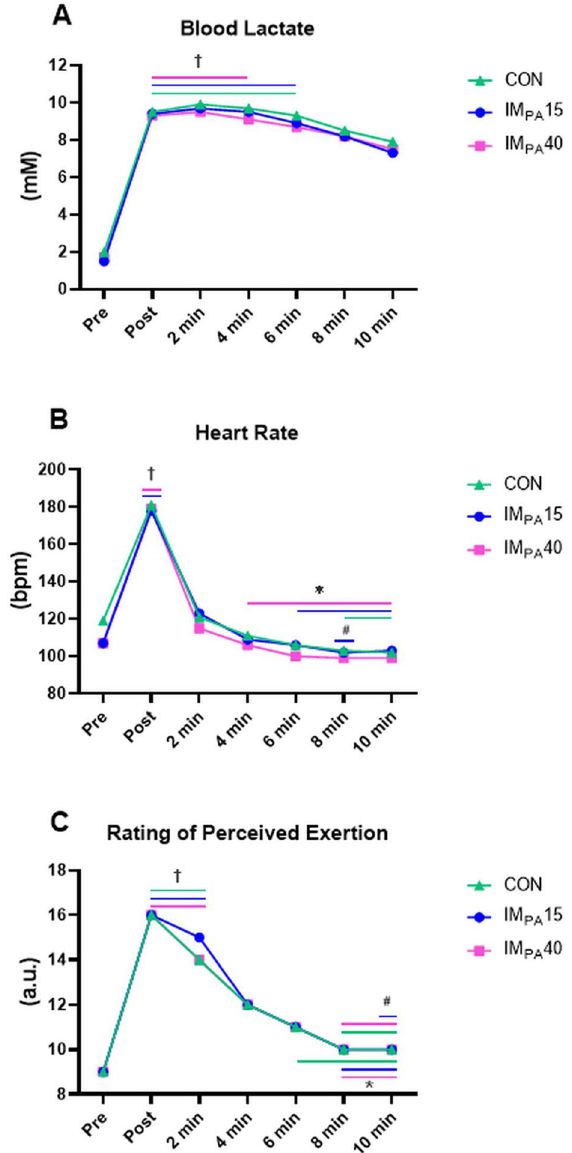
Figure 3. Physiological and psychophysiological parameters pre, post and recovery a judo match. The results are presented in mean values. ( A ) Blood lactate (mM); ( B ) Heart rate (bpm); ( C ) Rating of perceived exertion (a.u.). † Significant difference compared to the pre-combat moment; *significant difference compared to the post-combat moment; # significant difference compared to the 2 nd min post-combat ( p ≤